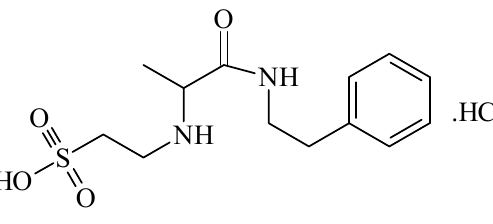
Figure 9. Structure of N -isopropylamine-2-(1-phenylethyl)aminoethanosulfonic acid hydrochloride (TAU-15, taurepar).